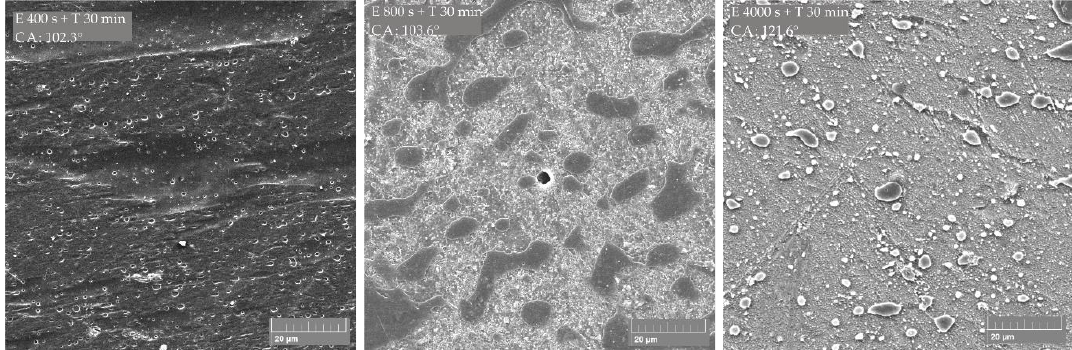
Figure 6. SEM micrographs of PLA / PE-HD 90 / 10 polymer blend treated by etching (E) and CF x coating (T); measured contact angle is indicated as coating (T); measured contact angle is indicated as CA